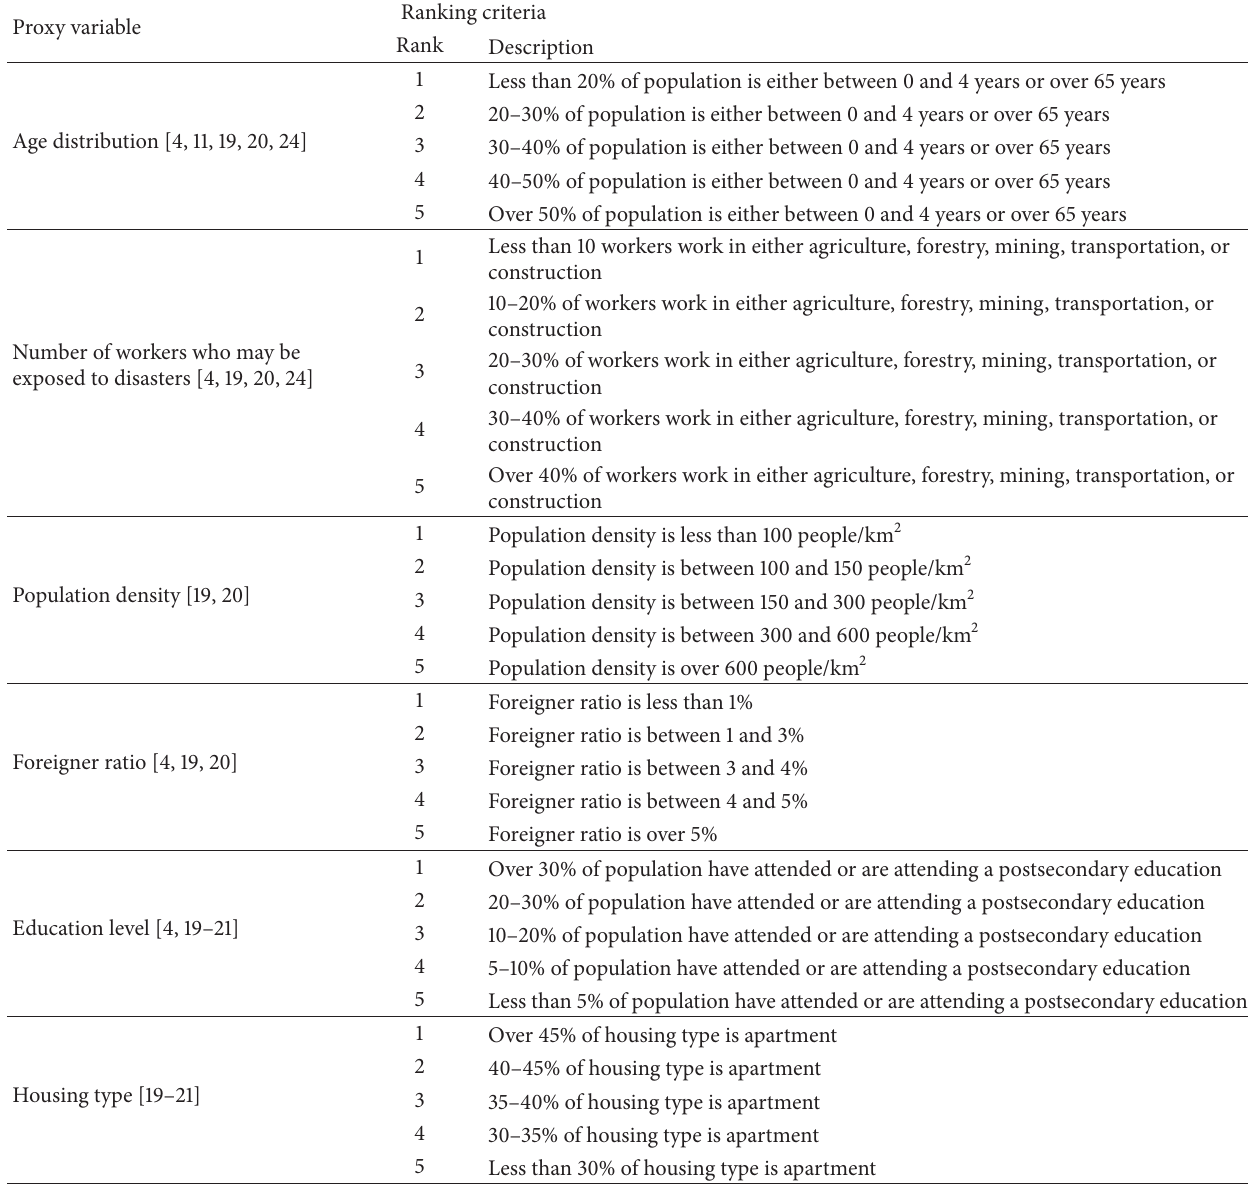
Table 4: Criteria for ranking of proxy variables of